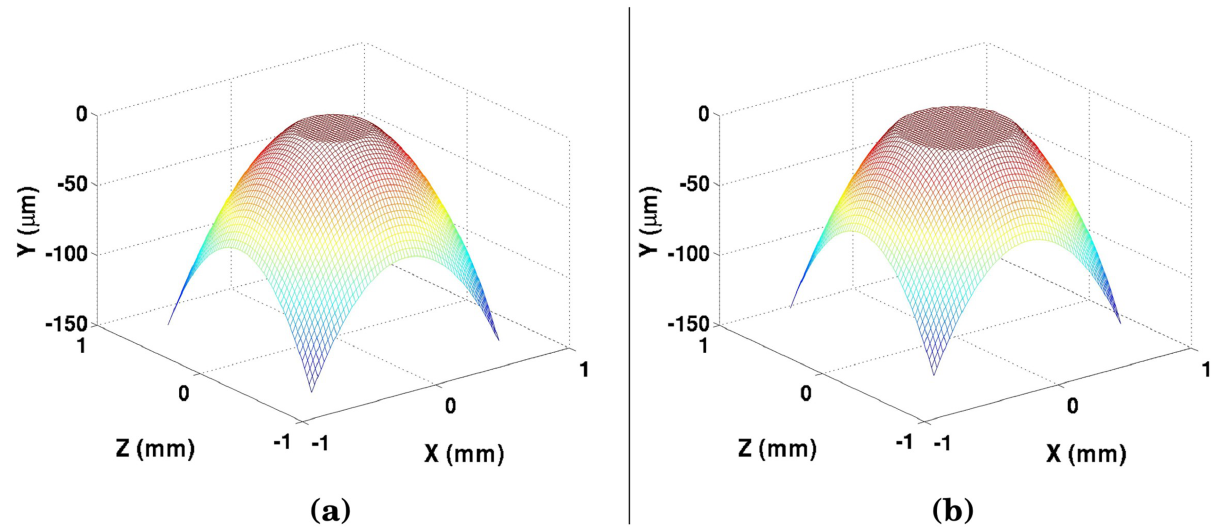
Fig 4. Film thickness profile after 3600 seconds of contact, at both (a) 25˚C and (b) 59˚C.